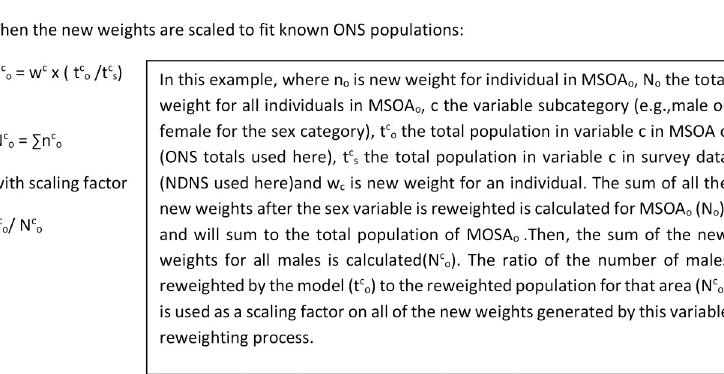
method of small-area estimation for smoking prevalence has been validated using data from a full population census in New Zealand [42]. Another consideration is the internal goodness- of-fit in the modelled populations, with the preference being standardised Total Absolute Error (TAE) between the observed and estimated demographic variables used to predict the outcomes (here, age, sex, and so on) [49]. Observed values are gained from the Census and ONS and the mean TAE for each constraint variable is calculated across the 6791 MSOAs in England. As there are no readily available comparable datasets of SSB or fruit and vegetable consumption in England at the MSOA level [38], the focus of model fit is on the internal comparisons.